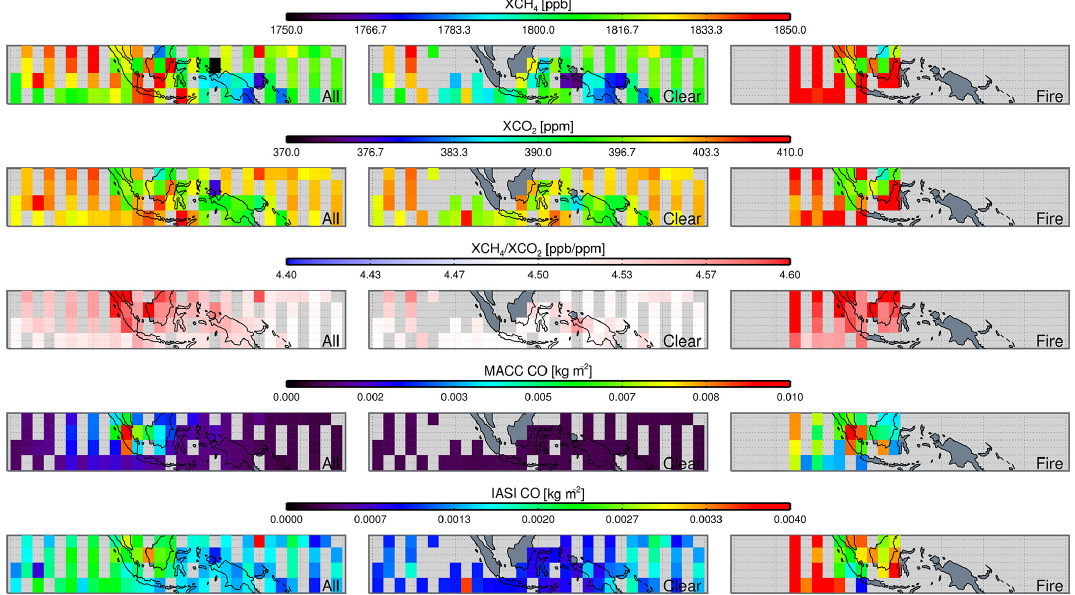
Figure 6. Indonesia trace gas distributions for September–October 2015 showing (top to bottom): the GOSAT-retrieved XCH 4 , XCO 2 and XCH 4 / XCO 2 ratio, along with the CAMS carbon monoxide (CO) total column and the measured IASI CO total column. The left column shows all data gridded at 2 ◦ × 2 ◦ , the central column shows only those points determined to be clear using the criteria of Sect. 4 and the right column shows the data determined to be fire affected based on the same criteria.